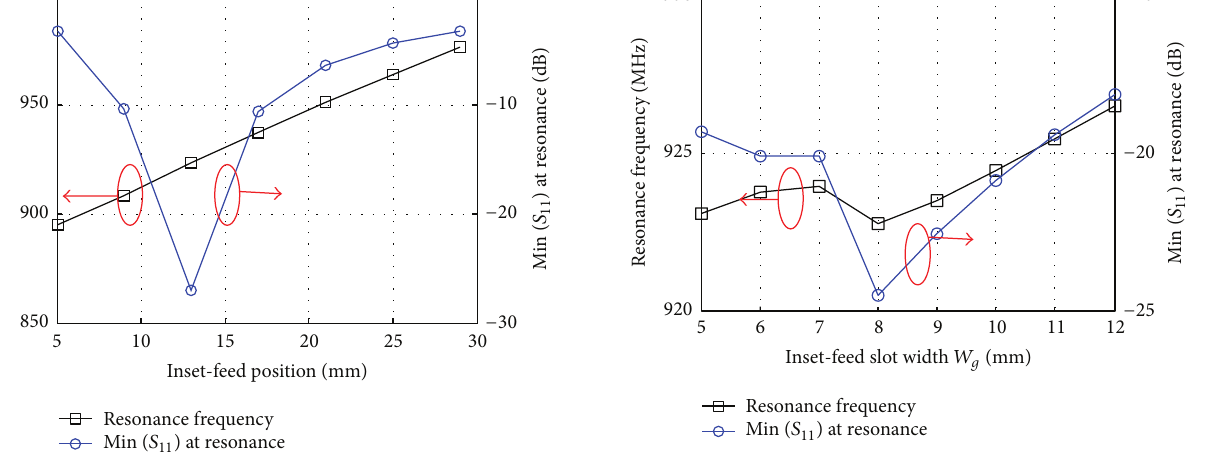
Figure 4: Simulated antenna resonant frequency and minimum reflectioncoefficientwithinthespecifiedbandwidthversusvariation of feed position 𝑦 0 .